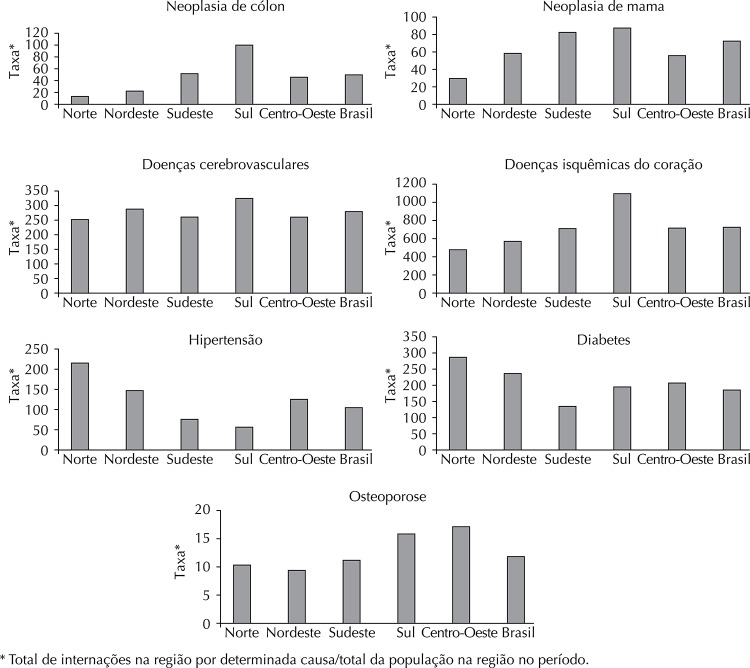
Taxa de internações no Sistema Único de Saúde por 100.000 habitantes, segundo causa e regiões do Brasil, 2013.